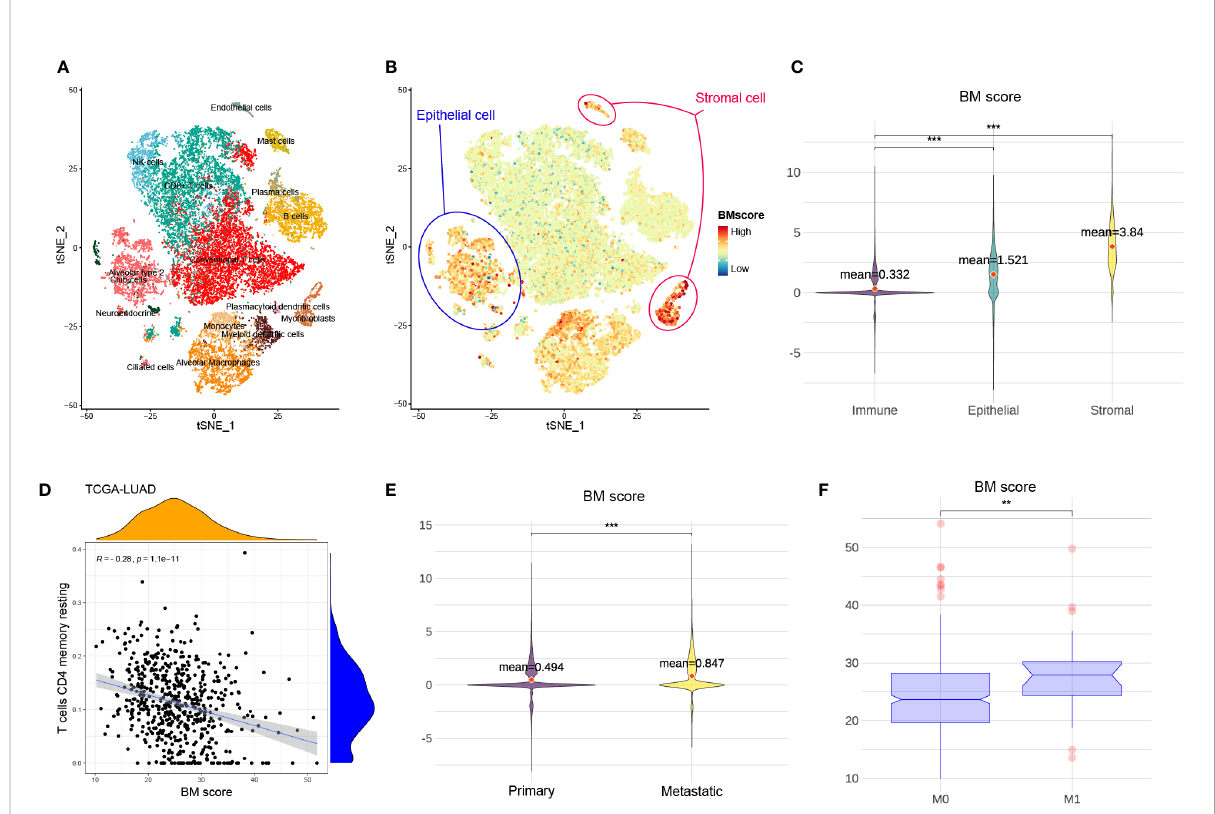
FIGURE 3 The relationship between BM score and different types of cells and tumours. (A) t-SNE scatters plot of eight primary and fi ve metastatic LUAD samples with cell annotation. (B) The distribution of BM scores at the single cell level. Blue and red circles represent epithelial and stromal cells, respectively. The rest of the scatter plot is fi lled with immune cells. (C) The violin plot demonstrating the difference in BM score among immune, stromal and epithelial cells. And the red dots indicate the average value of BM scores for each group. (D) The relationship between BM score and the abundance of T cells CD4 memory resting in TCGA-LUAD cohort. (E) The violin plot showing the difference in BM score between primary and metastatic LUAD tumour cells. Further, the red dots indicate the average value of BM scores for each group. (F) The distribution of BM score between tumours with non-metastatic (M0) and metastatic (M1). **p<=0.01 and ***p<=0.001,